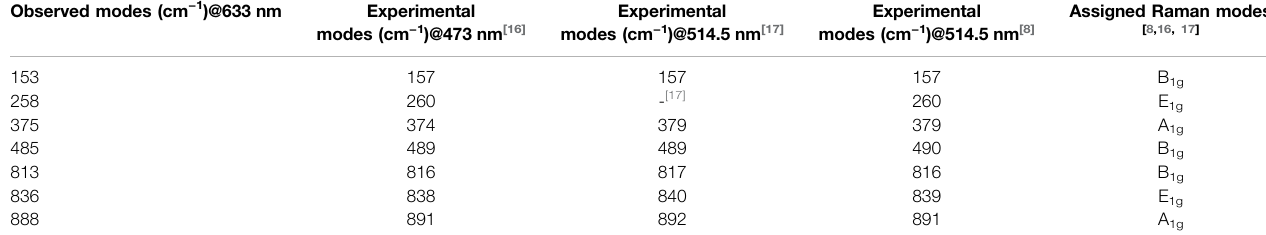
TABLE 2 | Observed modes of YVO 4 crystals and the corresponding experimental results. Observed modes (cm − 1 )@633 nm